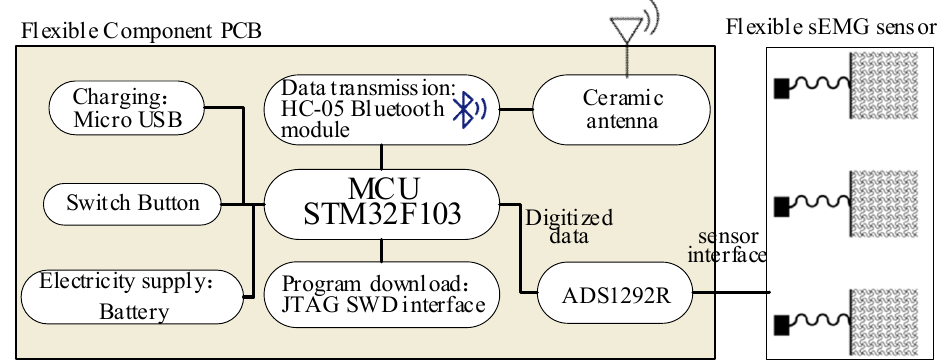
Figure 2. Overall framework figure of hardware.